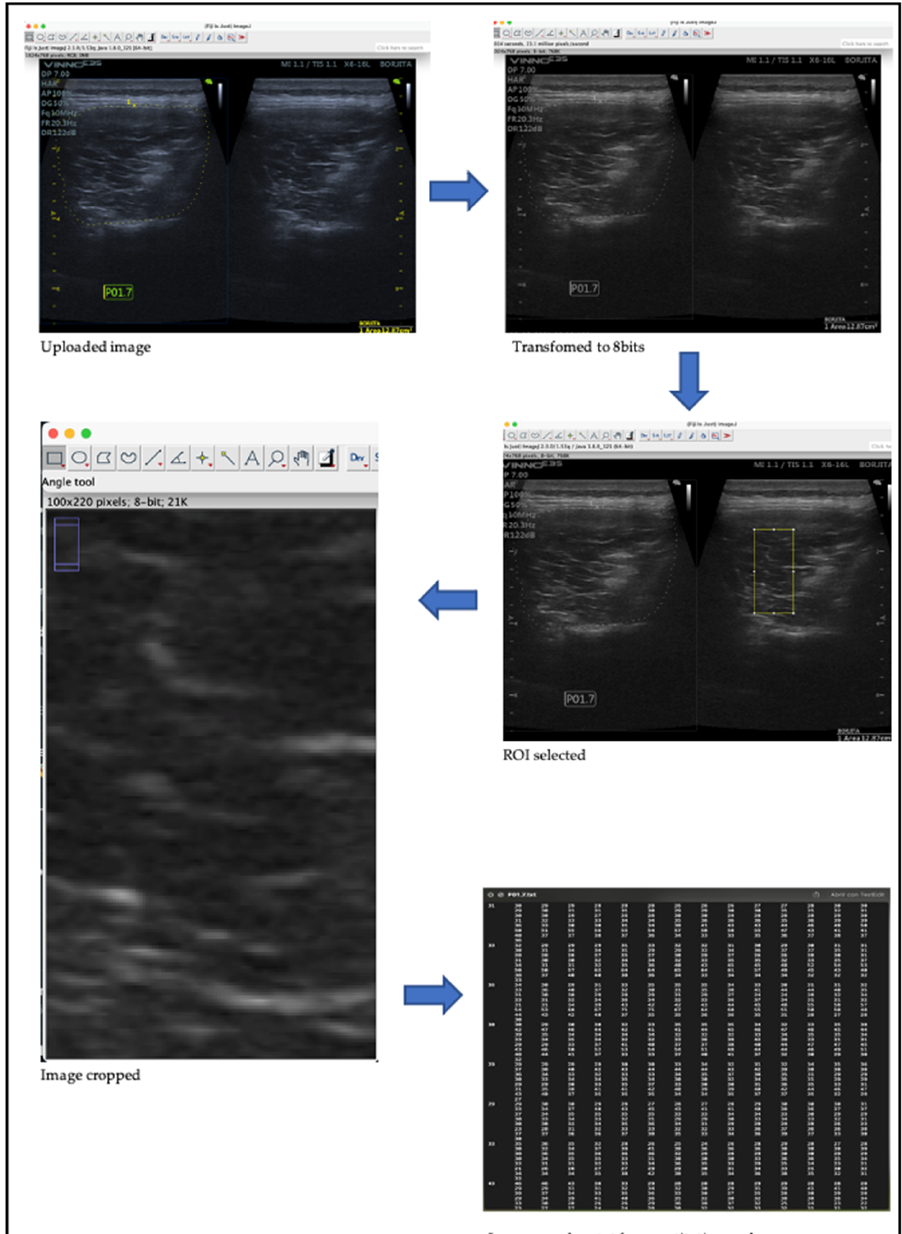
Scheme 1. Imagen processing previous quantitative